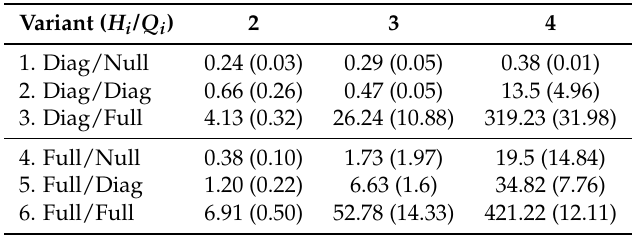
Table 5. Computing time (in seconds) for the whole procedure by number of principal components and for the six model variants. Mean values are obtained from four one-step-ahead predictions of the simulated signal. Standard deviations are reported in